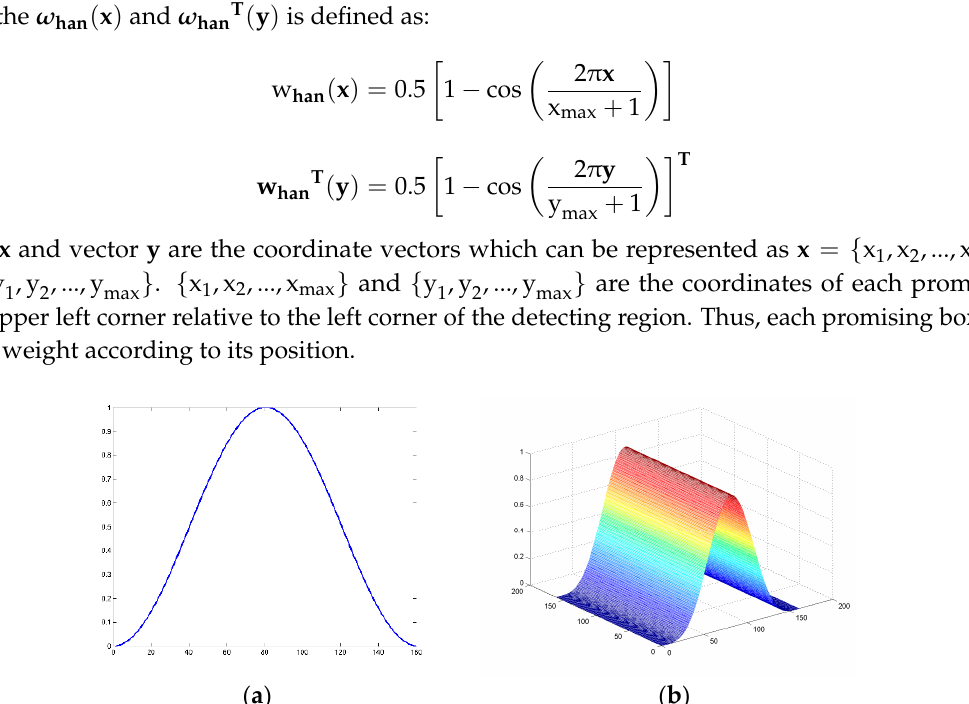
Figure 6. Simulation of the function: ( a ) Hanning window function; and ( b ) location-weighted function.